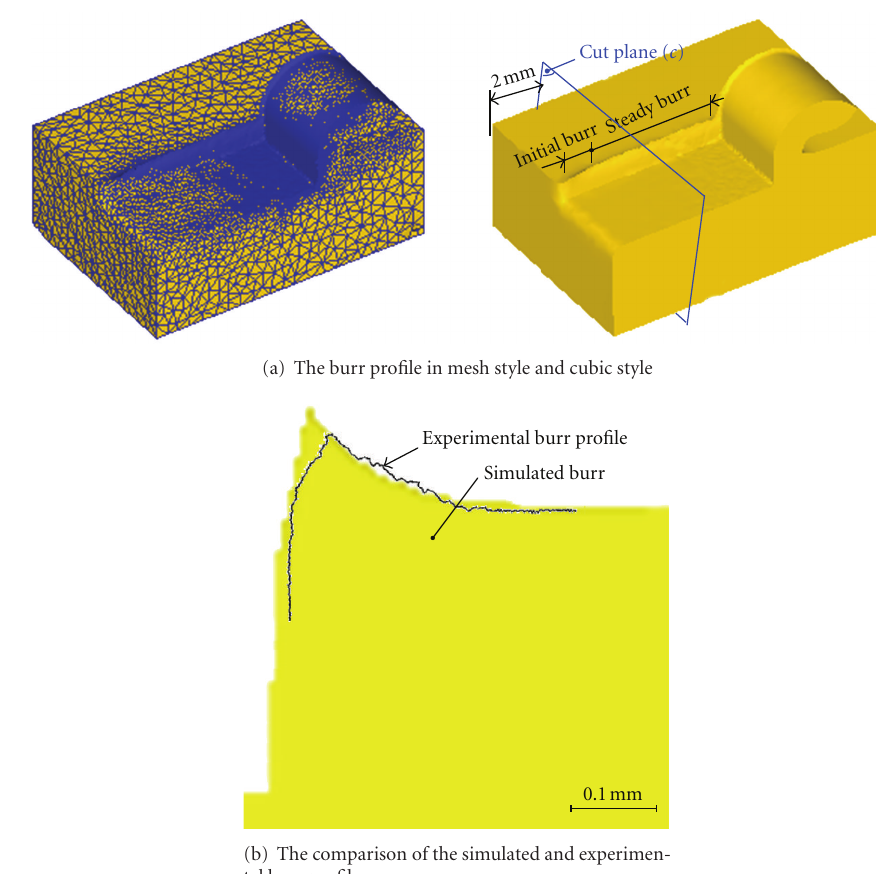
Figure 7: Burr formation at the top edge in rectangular groove